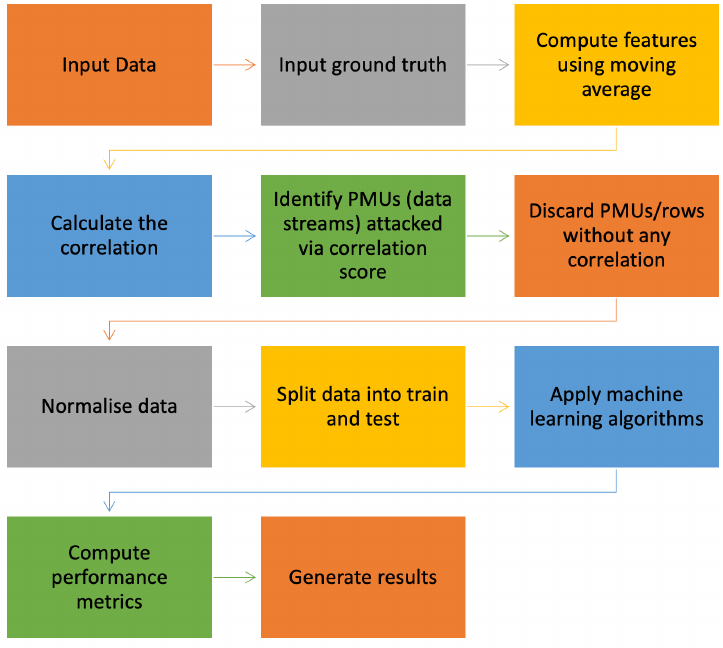
Figure 2. Detection of False Data Injection using machine